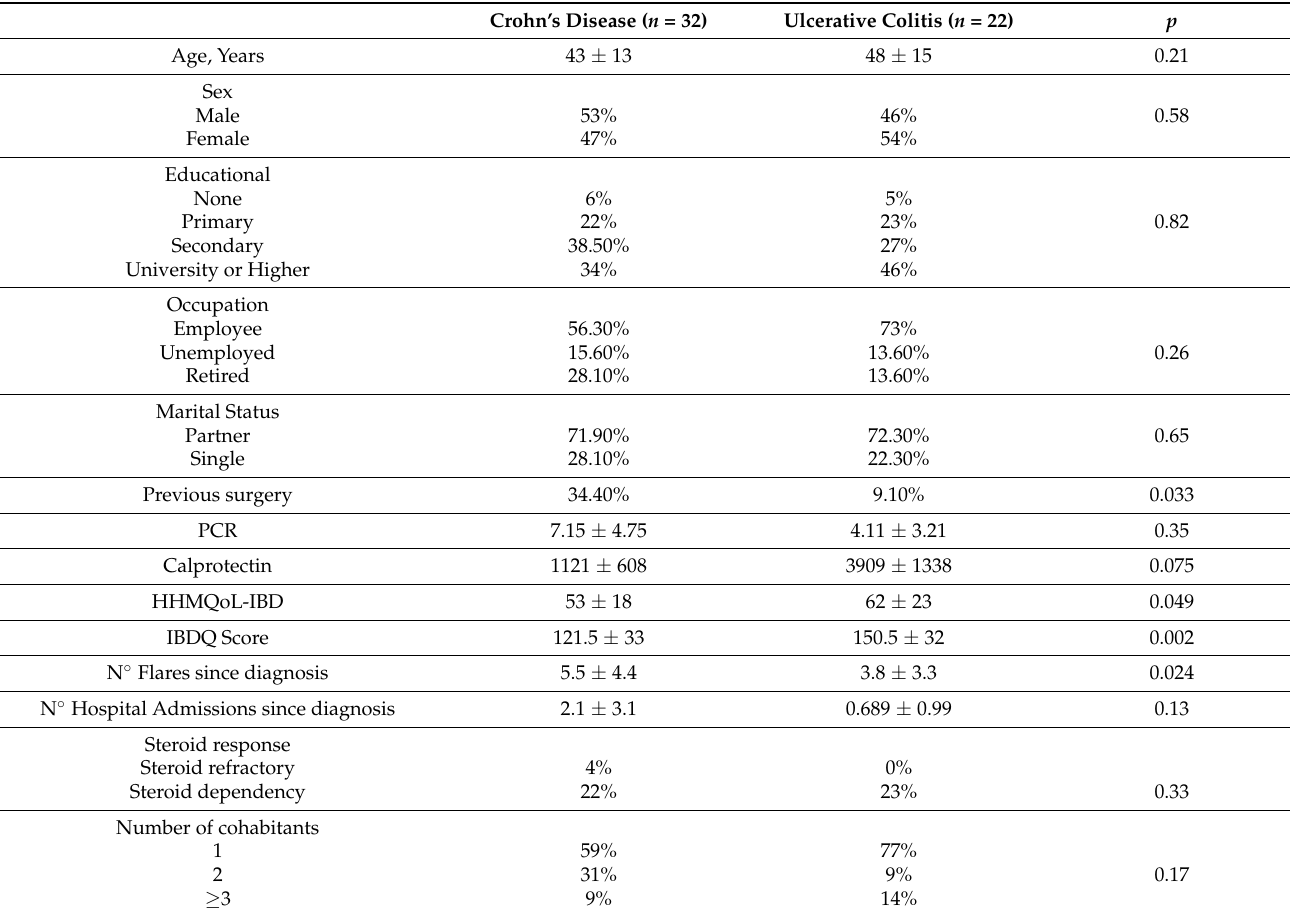
Table 3. Comparative characteristics of Crohn’s disease and ulcerative